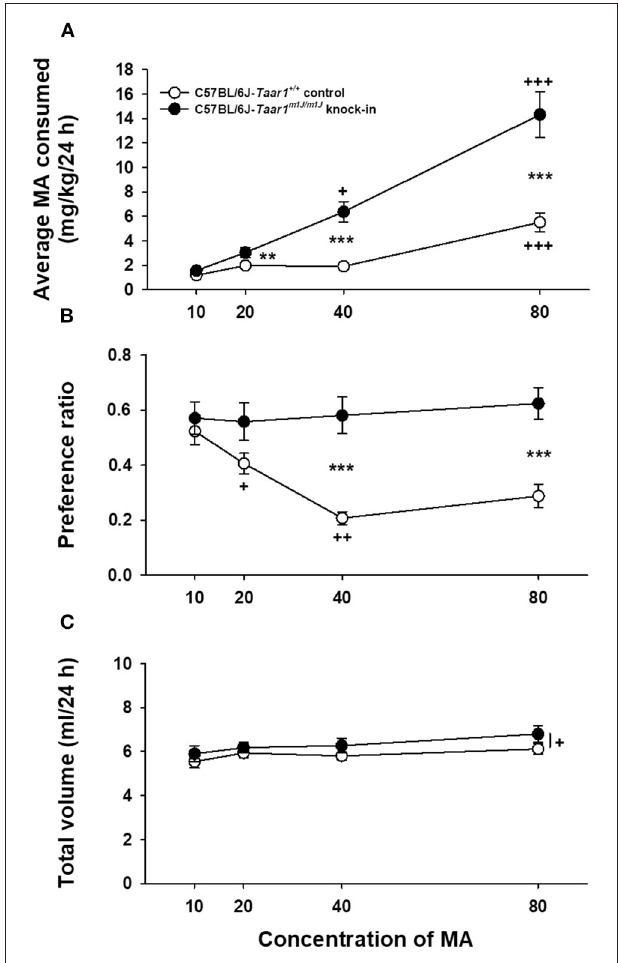
FIGURE 5 | DBA/2J -Taar1 m 1 J / m 1 J control mice consume more MA and exhibit greater MA preference, compared to DBA/2J- Taar1 + / + KI mice. Shown are means ± SEM for (A) average MA consumed (mg/kg/24h), (B) preference ratio (ml from MA tube/total ml consumed), and (C) total volume consumed (ml/24h) during two-bottle choice of water and ascending concentrations of MA. Each concentration was offered for a 4-day period. Total N = 32 mice (eight per mouse line per sex); * p < 0.05, ** p < 0.01, *** p < 0.001 for the difference between mouse lines for a given concentration (A) or collapsed on concentration (B) ; ++ p < 0.01, +++ p < 0.001 for the effect of concentration compared to the previous concentration (A) or for the main effect of concentration (B,C) . MA, methamphetamine; Taar1 + / + , homozygous